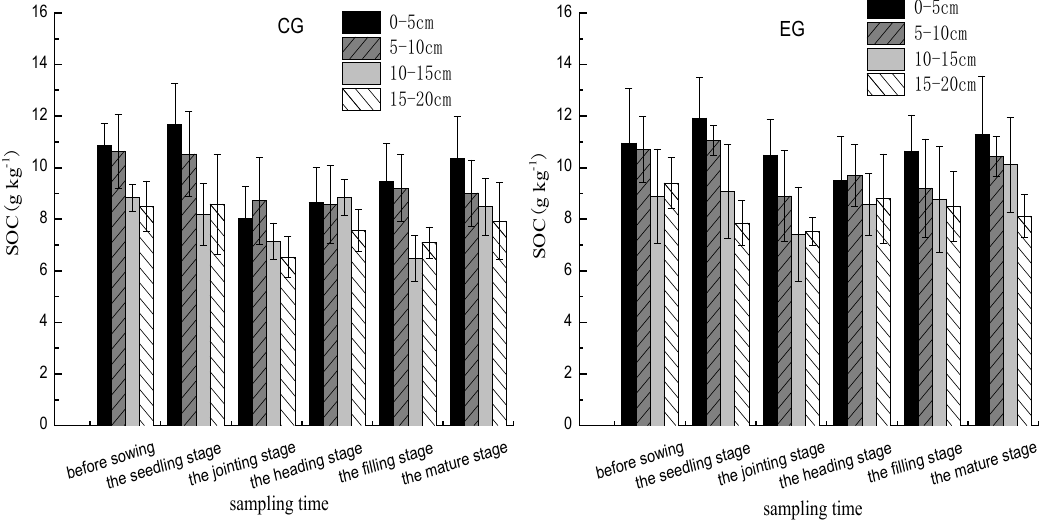
Figure 3: SOC concentrations in the control group (CG) and the experimental group (EG) soils subject to poultry wastewater